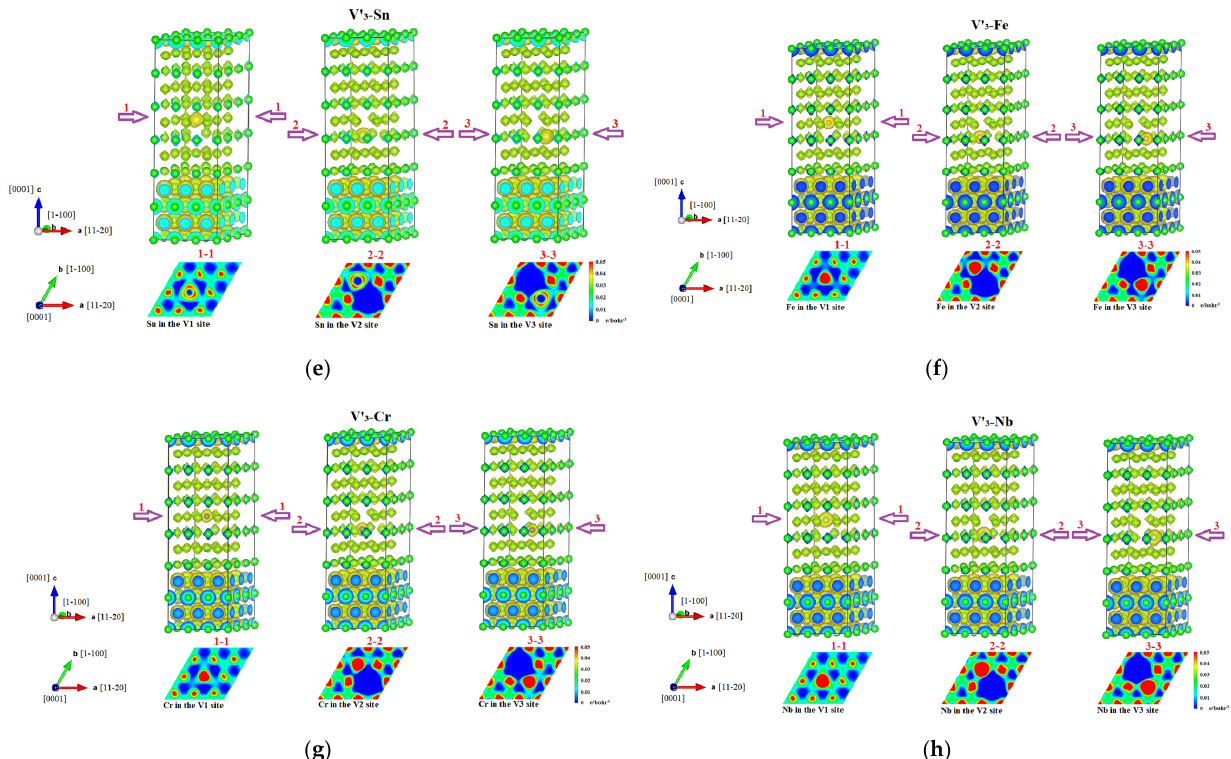
Figure 2. ( a − d ) Atomic structure and charge density distribution of 142-atom supercells, and ( e − h ) 141-atom supercells with different sites for one vacancy, two vacancy, and one alloying element Sn, Fe, Cr, or Nb. The figures were rendered with VESTA code